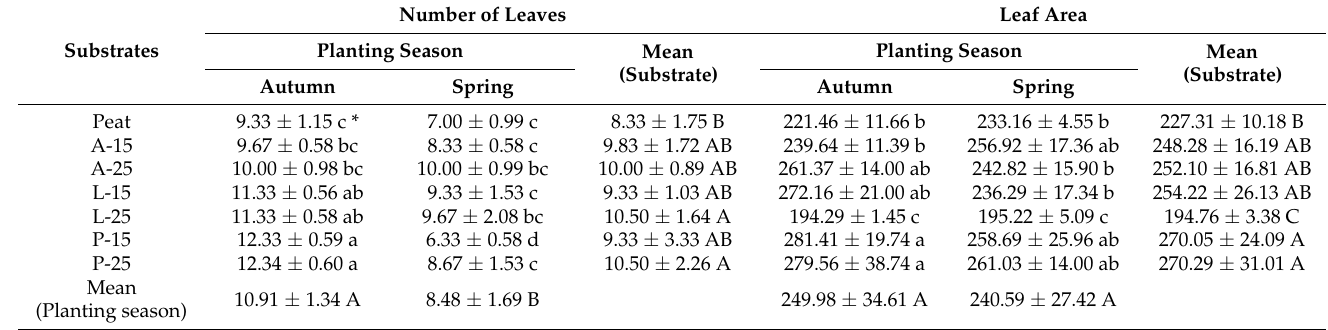
Table 8. The number of leaves and leaf area (cm 2 ) as influenced by substrates and planting seasons. Number of Leaves Leaf Area Substrates Mean (Substrate)